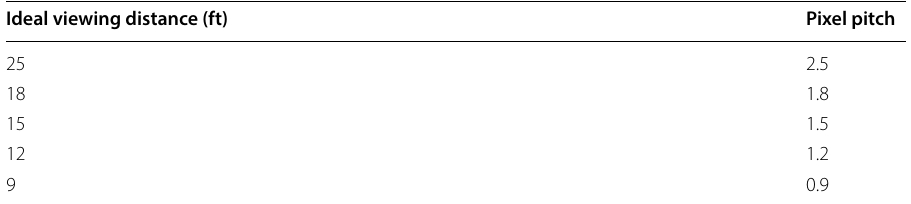
Table adapted from